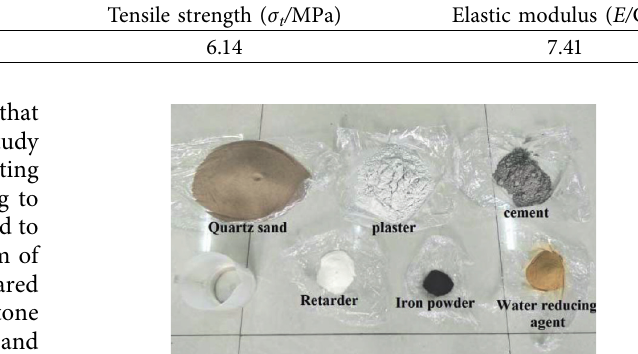
Table 1: Physical and mechanical parameters of white sandstone covered by the study.